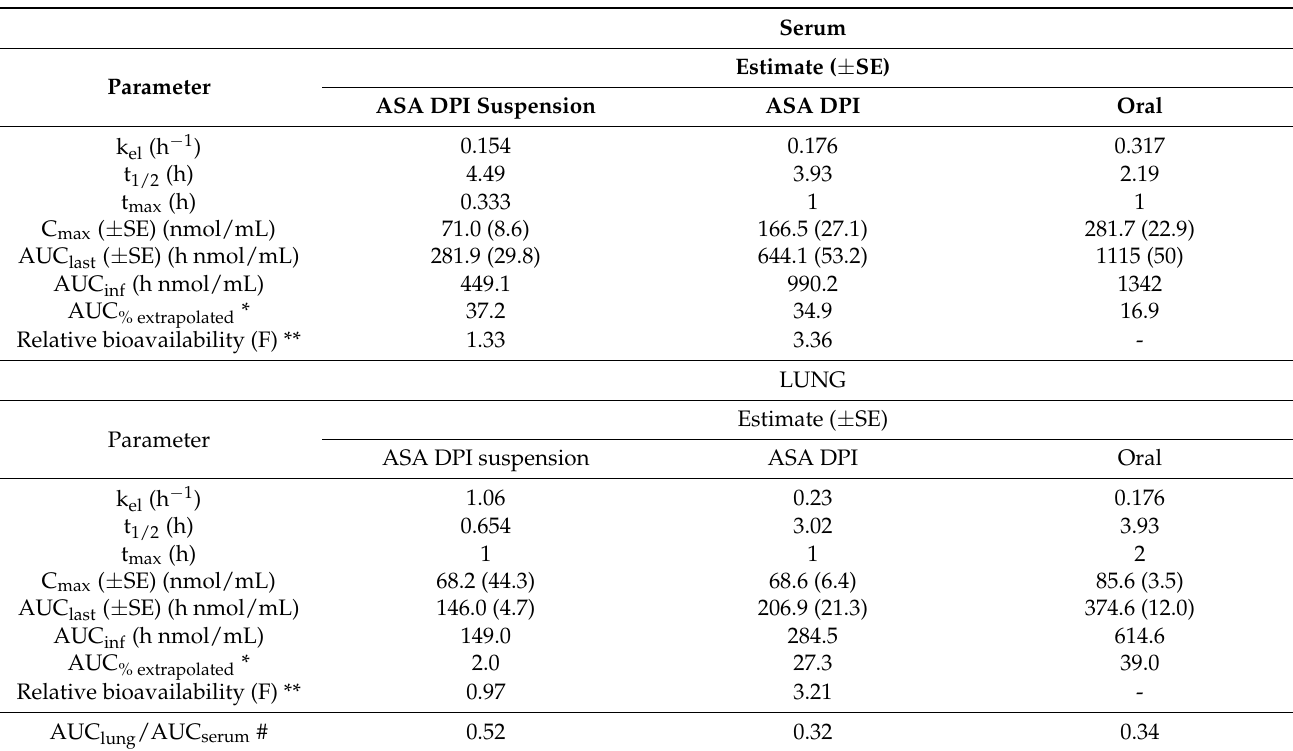
Figure 6. Serum ( A ) and lungs ( B ) SA time profiles after insufflation of ASA DPI ( ▲ ) and nebuliza- tion of ASA DPI suspension ( ♦ ) and after oral administration of ASA saturated solution ( ● ). Data (n = 5) are expressed as mean ± SD. Table 3. Estimated SA serum and lung PK parameters applying NCA sparse data analysis using Phoenix ® for all tested routes of ASA and ASA dry powder (ASA DPI)